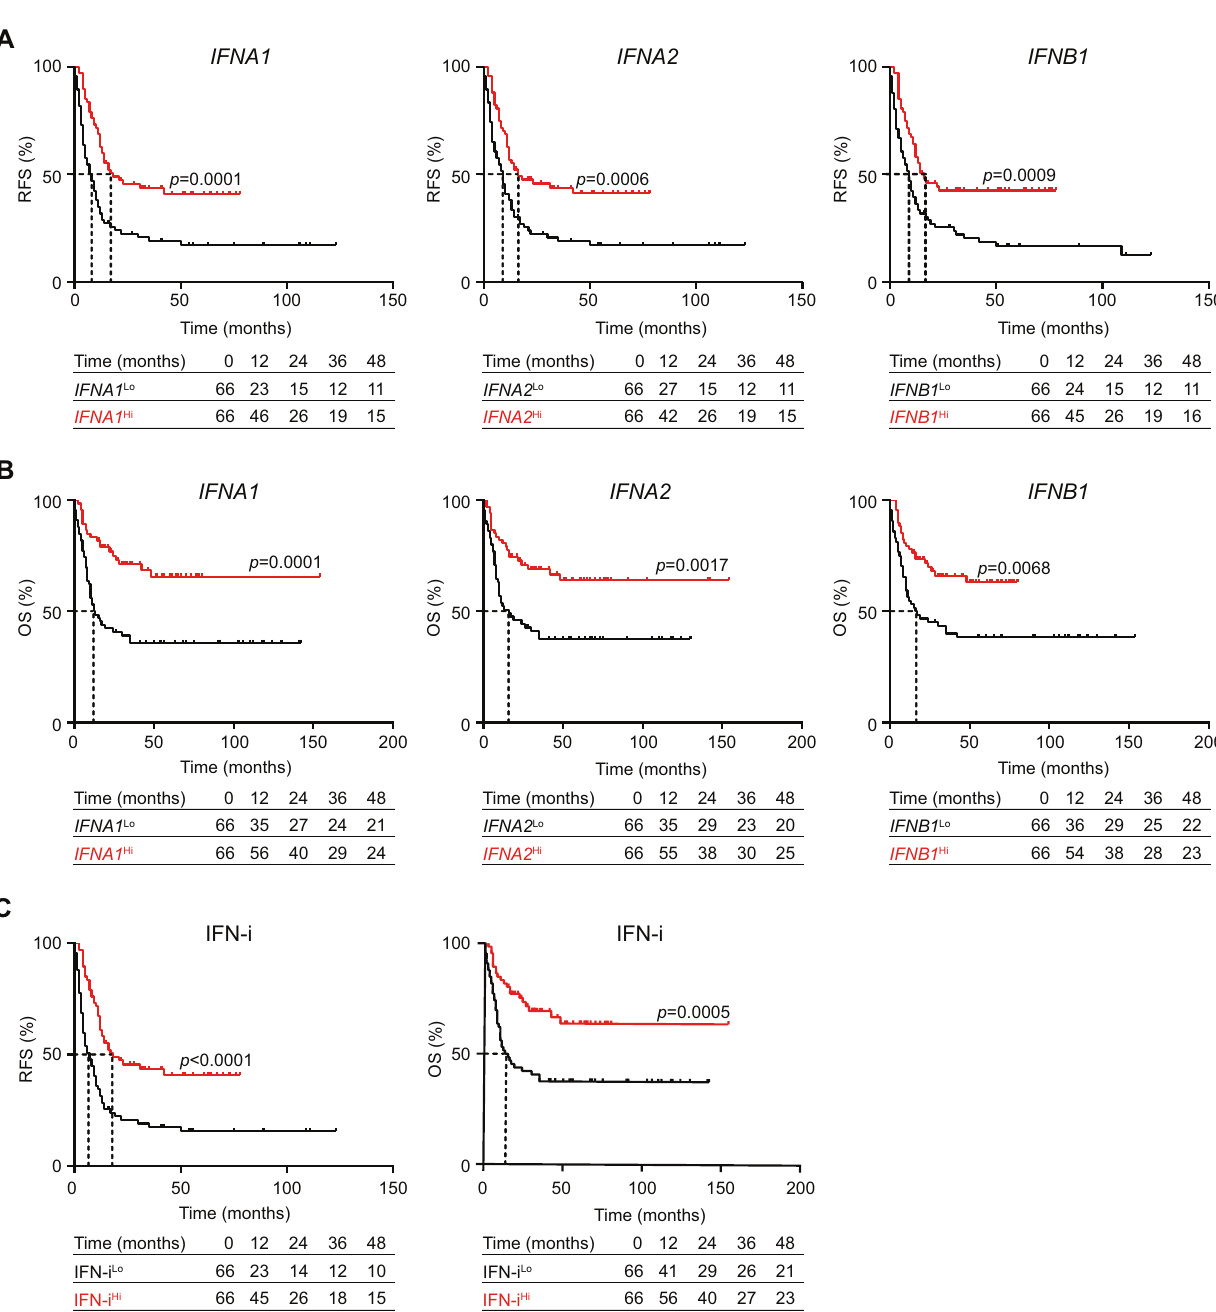
Fig. 5 Type I IFN levels correlate with improved disease outcome in patients with AML. A – C Relapse-free (RFS) and overall survival (OS) of 132 AML patients from Study Cohort 1 upon median strati fi cation based on IFNA1 , IFNA2 , IFNB1 expression or type I IFN index (IFN-i). Survival curves were estimated by the Kaplan-Meier method, and differences between groups were evaluated using log-rank test. Number of patients at risk and p values are